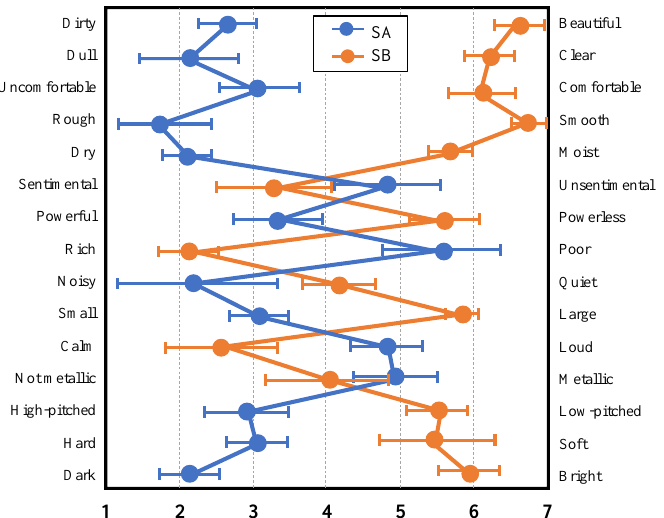
Figure 6. Results of the profile analysis of the subjective evaluation experiment. All the results for each of the subjects were arithmetically averaged and as a profile. The blue dots are the results for SA, while the orange dots are those for SB. There is a large difference between these two sounds with significant differences for all items ( p < 0.05).